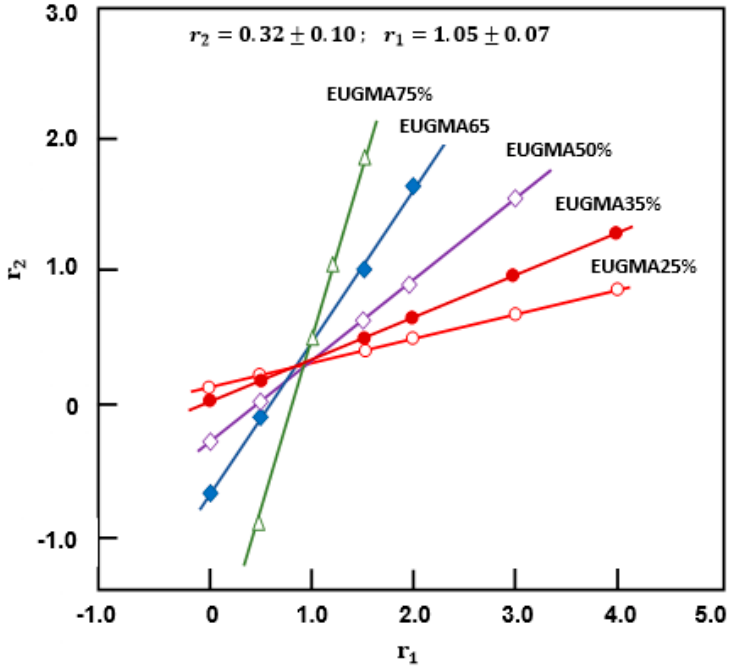
Figure 9. Curves indicating the variation of r 2 vs. r 1 obtained from Mayo–Lewis equation.